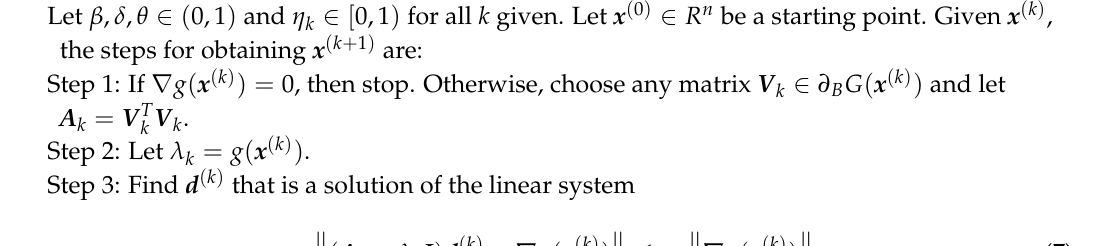
Algorithm 2: The inexact version of the damped Gauss-Newton method for solving